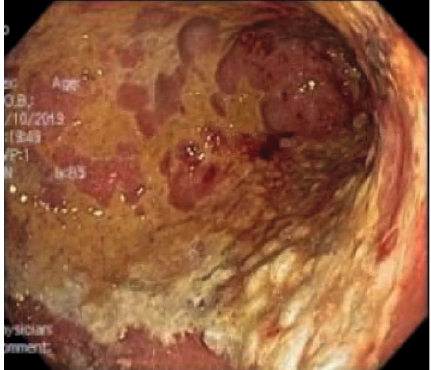
Figure 2: EGD image of body of stomach showing ulceration secondary to CMV.